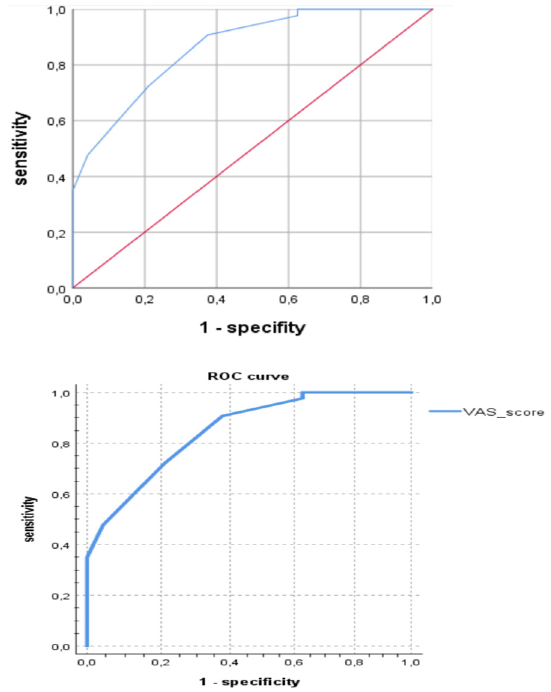
Figure 1. Diagnostic accuracy of VAS score (ROC curve: area under the curve (AUC) = 86.2%, p < 0.05) in PE predicting on laparoscopy (baseline is in red, the VAS score line is in blue). Routine blood tests revealed no between-the-group differences, apart from slightly higher eosinophil counts in patients with PE compared to healthy controls (10 8 /L; 2.6 ± 2.2 vs. 1.9 ± 2.1, p = 0.04). The measured values of other inflammation markers including total WBC counts (10 9 /L; 6.5 ± 1.8 vs. 6.9 ± 2.4, p = 0.4), sedimentation rate of erythrocytes (ESR) (cm/h; 3.4 ± 2.2 vs. 3.3 ± 1.6, p = 0.8) and C-reactive protein (CRP, mg/L; 0.9 ± 0.9 versus 1.0 ± 0.6, p = 0.9) were similar.